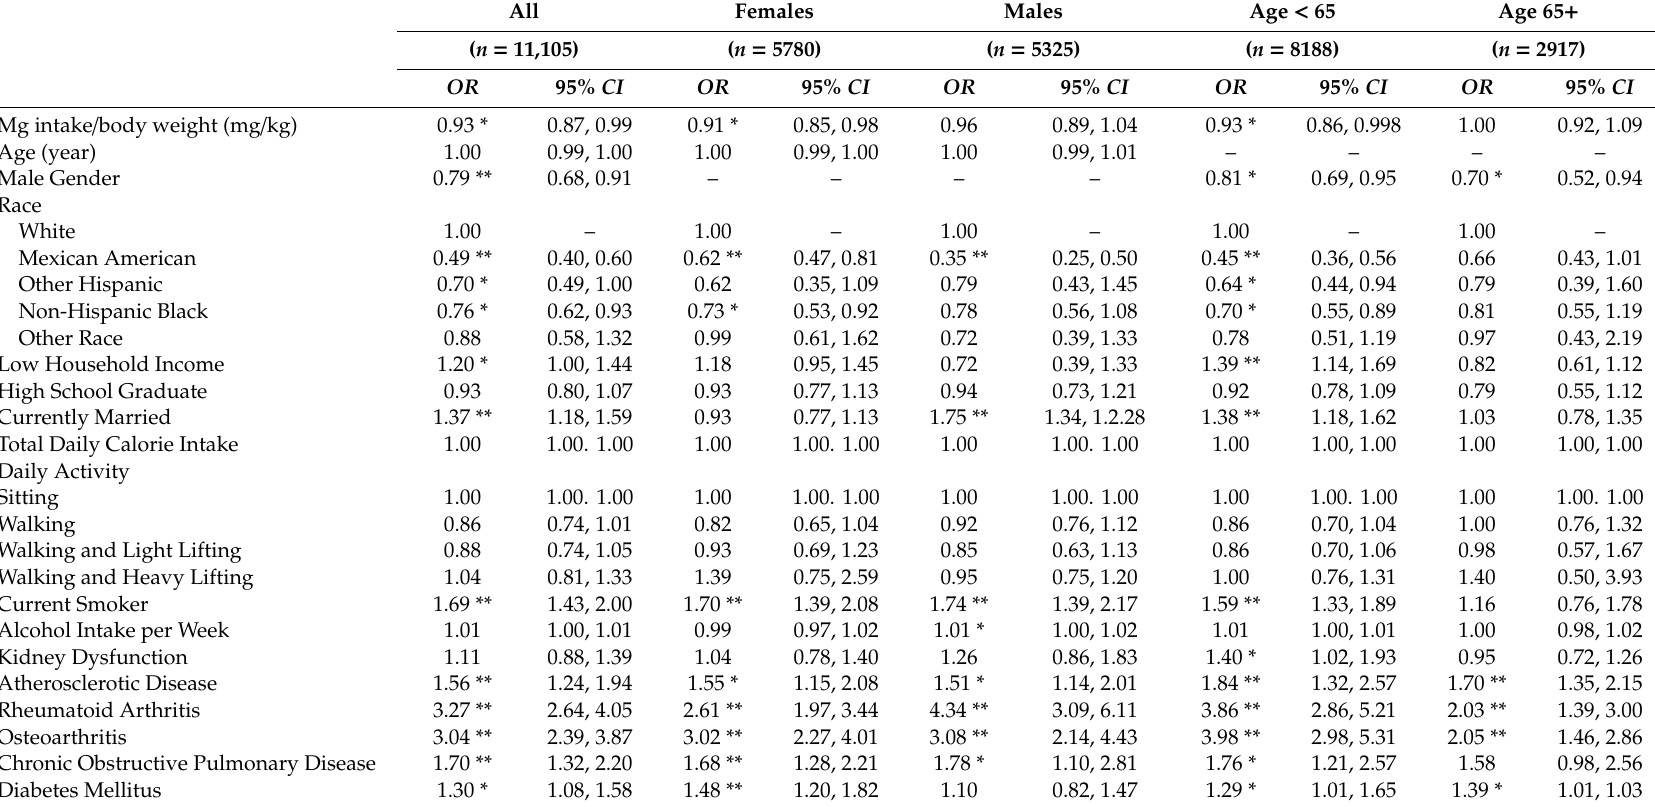
Table 2. Multivariate logistic regression analyses of magnesium intake per day per kg on chronic